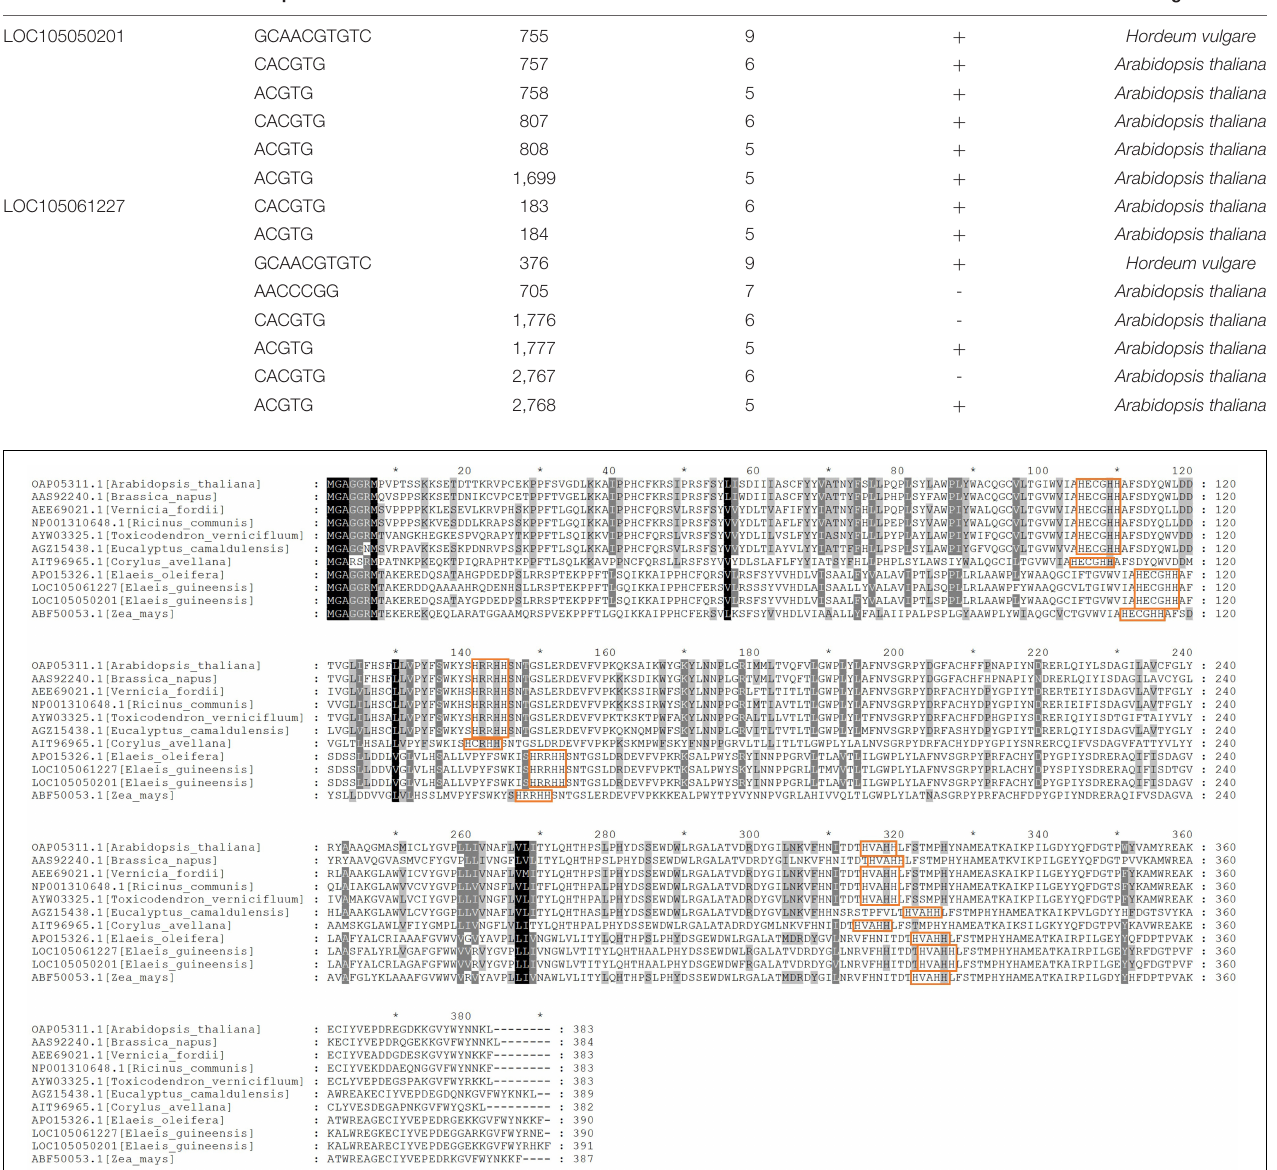
FIGURE 6 | An alignment view of two FAD2 copies. Red blocks represent histidine-rich